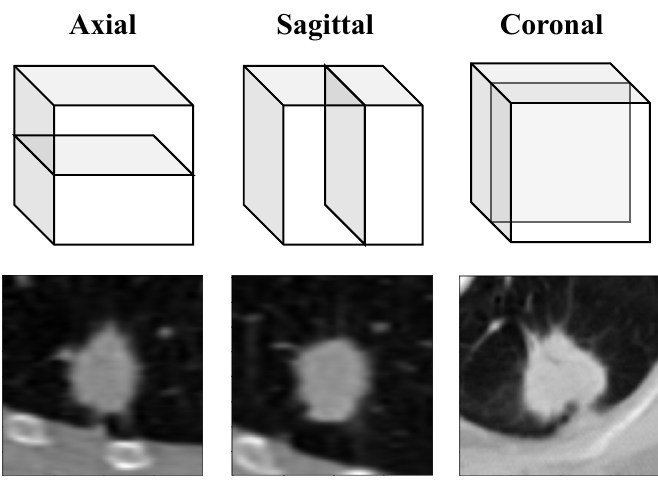
Figure 1. Lung nodule slice extraction example: middle slice from axial, sagittal and coronal planes from the same 3D nodule.